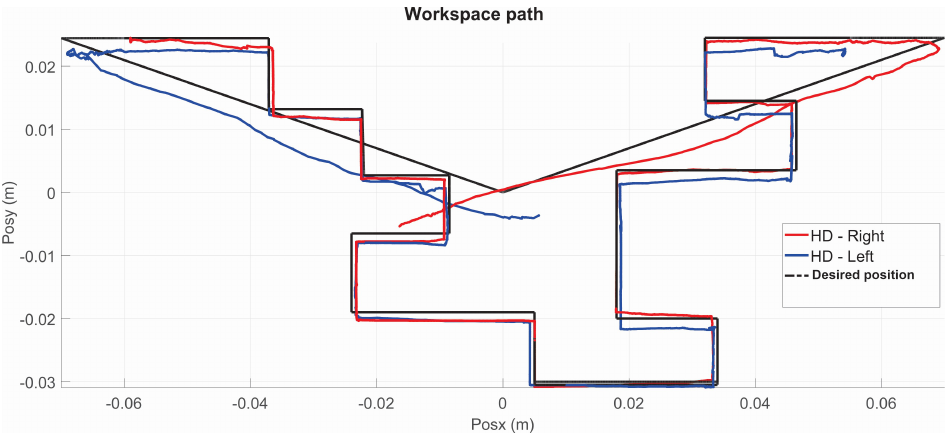
Figure 27. Workspace trajectory of two haptic devices in passive haptic guidance task: exercise 3.